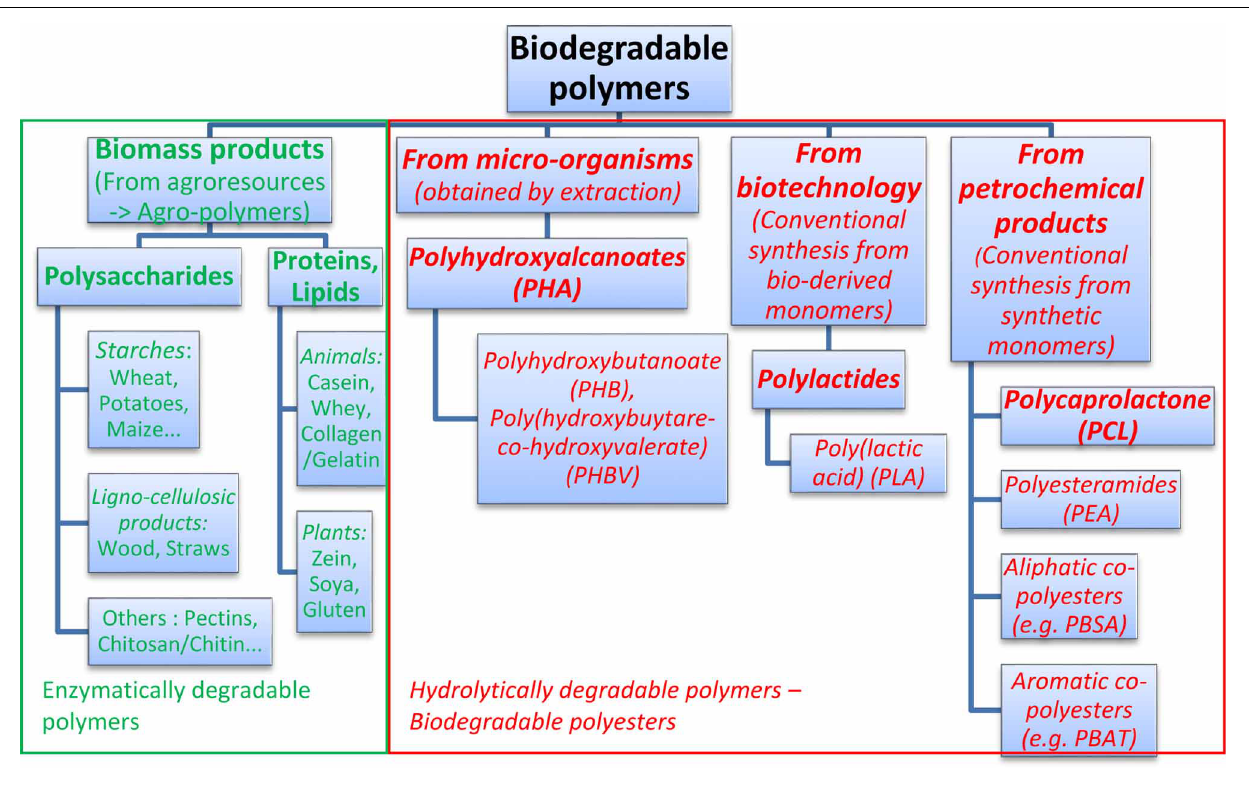
FIGURE 1 | Classification of the most known biodegradable polymers.